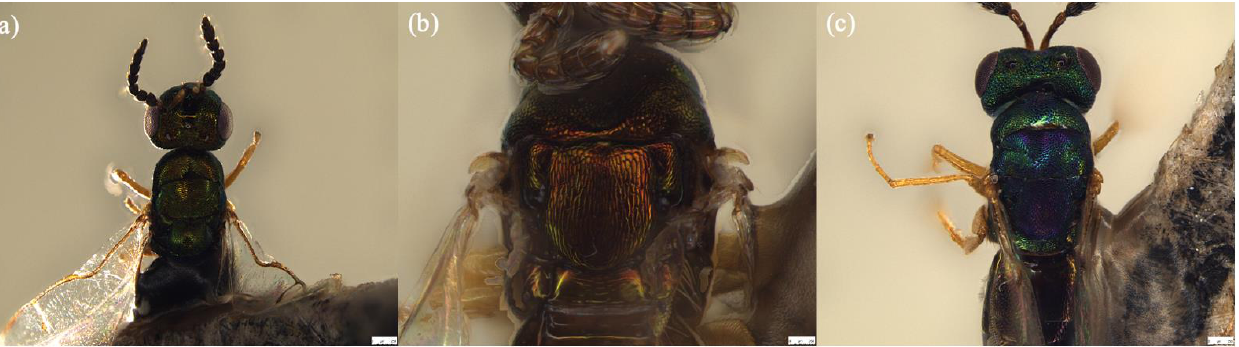
Figure 5. Habitus lateral view of ( a ) Sycoscapter chinensis sp. n.; ( b ) S. thaiensis sp. n.; ( c ) S. singaporensis sp. n. Head, dorsal of ( d ) S. chinensis ; ( e ) S. thaiensis ; ( f ) S. singaporensis . Noted that S. thaiensis and S. singaporensis have deep face sculptures. Scale bars on the stacked images are 250 μm.